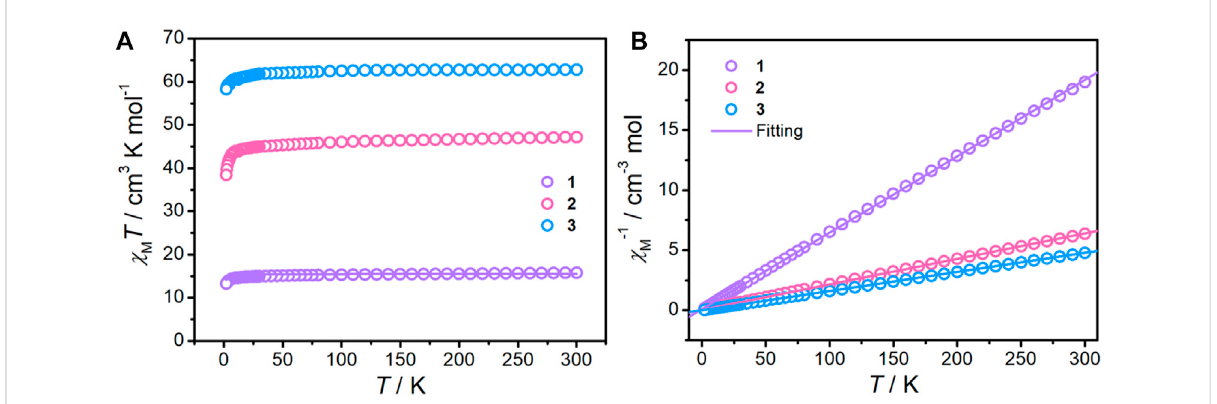
χ M T product with cooling and the result of the Curie – Weiss Law.